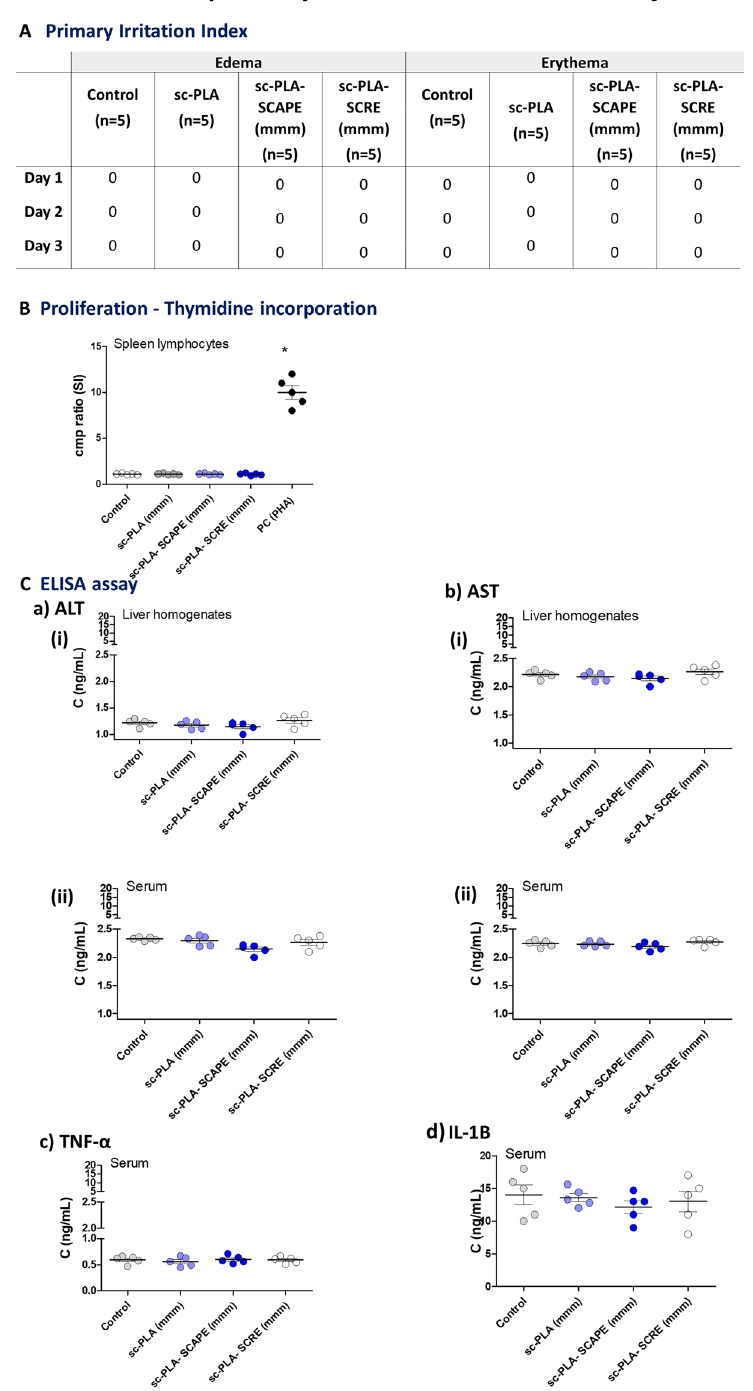
Figure 5. In vivo biocompatibility assessment of studied microparticles in guinea pigs injected subcutaneously. Tested S. cadmica extracts alone, stereocomplexed microparticles sc-PLA (mmm) alone or sc-PLA (mmm) loaded with S. cadmica aerial part extract— sc-PLA-SCAPE (mmm), S. cadmica root extract—sc-PLA-SCRE (mmm) or physiological saline were subcutaneously injected to guinea pigs. Guinea pigs were monitored for 72 h for adverse skin reactions (A). The appearance of edema and erythema was assessed and graded daily according to the Primary Irritation Index (PII) = 0/3, where 0 indicates that the irritation is negligible. At 72 h post-injection, the animals were terminated and spleen, liver and blood samples were collected for further evaluation. (B) Splenic lymphocytes were tested for proliferation towards mitogen—phytohemagglutinin (PHA) as positive control (PC) by ( 3 H)-thymidine incorporation into cellular DNA. Stimulation index (SI) was calculated by dividing the radioactivity counts (cpm/min) of cells stimulated with S. cadmica extracts or microparticles by the radioactivity of cells in culture medium alone. ( C ) The level of alanine aminotransferase—ALT ( a ) and aspartate aminotransferase—AST ( b ) in liver homogenates ( i ) or in serum samples ( ii ); the level of tumor necrosis factor alpha—TNF-α ( c ) and interleukin (IL)-1B ( d ) in serum samples, detected by the enzyme linked immunosorbent assay (ELISA). Five animals per group were examined. The results are presented as median values ±